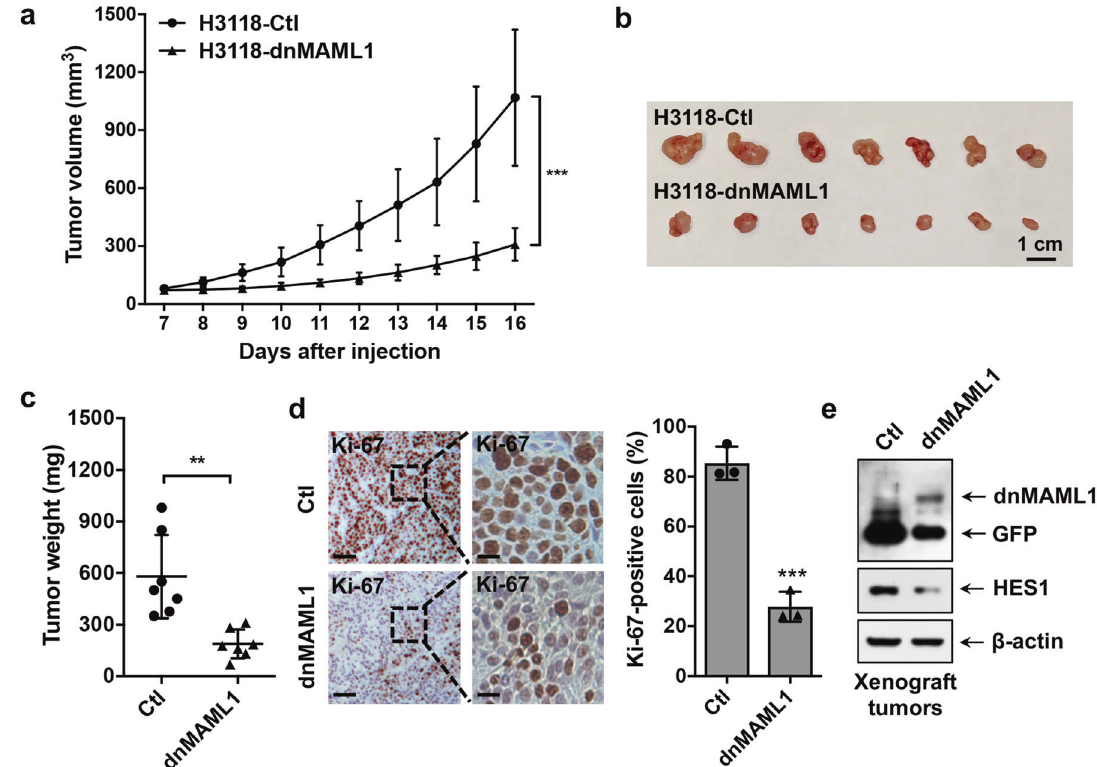
Fig. 3 Expression of a dominant-negative MAML1 reduced the growth of MEC xenografts. GFP-expressing and dnMAML1-expressing H3118 cells (1 × 10 6 cells/mouse) were subcutaneously injected to the right fl anks of 8 – 12-week-old immune-de fi cient NOD.SCID mice ( n = 7 each group). Mice were euthanized after a 16-day xenograft study. a – c The tumor volumes were measured daily after tumor cell injection ( a ), and tumor size ( b ) and tumor weight ( c ) were presented at the endpoint. d Representative images of Ki-67 staining of H3118-dnMAML1 and control H3118-GFP xenografts (left bar = 100 μ m, right bar = 25 μ m) were shown. ImageJ was used to analyze Ki-67-positive cells in IHC staining results. Sections of individual tumors ( n = 3) in each group were analyzed. The data were presented as the percentage (%) of Ki-67 positive nuclei to the total nuclei. e The expression levels of GFP, dnMAML1, and HES1 in xenograft tumors were analyzed by western blotting (** p < 0.01; *** p <